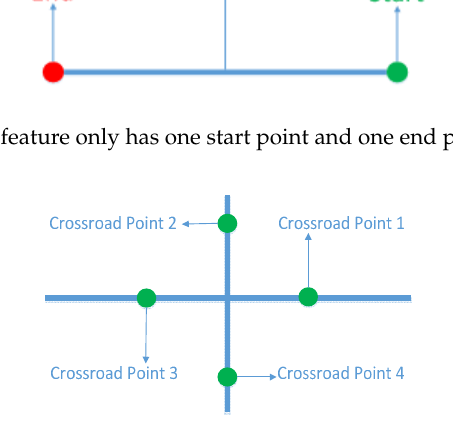
Figure 3. Every lane has its own GPS data line in the high accuracy Geographic Information System (GIS).